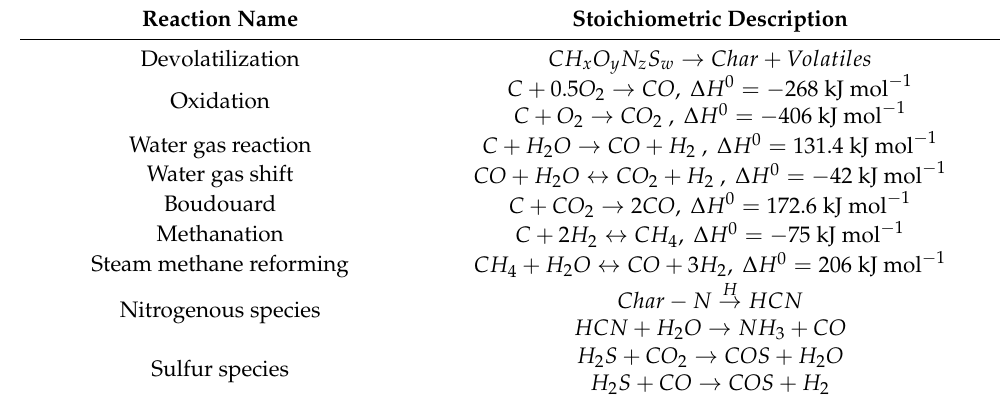
Table 5. Key chemical reactions within an EMIPG system reactor [50–53].